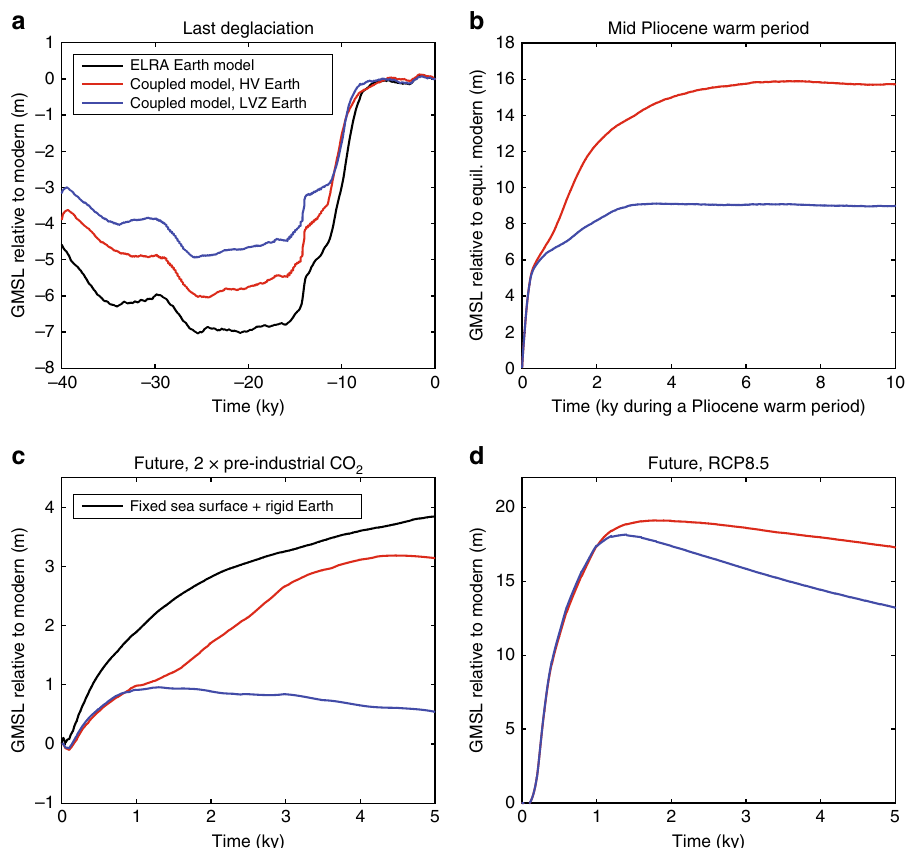
Fig. 6 Impact of sea-level changes and solid Earth deformation on Antarctic past and future ice sheet evolution. Frames show model-predicted contribution from the AIS to global mean sea level (GMSL) ( a ) over the last 40 ka relative to the modern, ( b ) during a 10 ka mid Pliocene warming of 2 °C relative to an initial state similar to the modern except that the Earth system has fully equilibrated from the last deglaciation, and ( c , d ) under future climate warming relative to a modern pre-industrial state at 0 model years in which ( c ) CO 2 is doubled and the oceans are warmed by 2°C at the start of the simulation, and ( d ) RCP 8.5 climate warming is applied and additional mechanisms promoting ice loss are included. The black line in a shows the results of a simulation that adopts an ELRA bedrock deformation model (relaxation time 3 ka) and no sea-level coupling. The black line in c shows the results of a simulation in which the positions of the solid Earth surface and sea surface are fi xed. Red and blue lines show output from a coupled ice sheet – sea level model that includes the feedback of solid Earth deformation and sea surface height changes on ice dynamics. These simulations adopt two different radially varying Earth models: “ HV ” (red lines) has a lithospheric thickness of 120 km and upper and lower mantle viscosities of 0.5 and 5× 10 21 Pas, respectively; “ LVZ ” (blue lines) has a 50km thick lithosphere, a low viscosity zone of 10 19 Pas down to 200km depth, and upper and lower mantle viscosities below that of 0.2 and 3 × 10 21 Pa s, respectively. Frames ( a ), ( b ) and ( d ) were created from results of Pollard et al. 15 , and frame ( c ) was created from the results of Gomez et al.